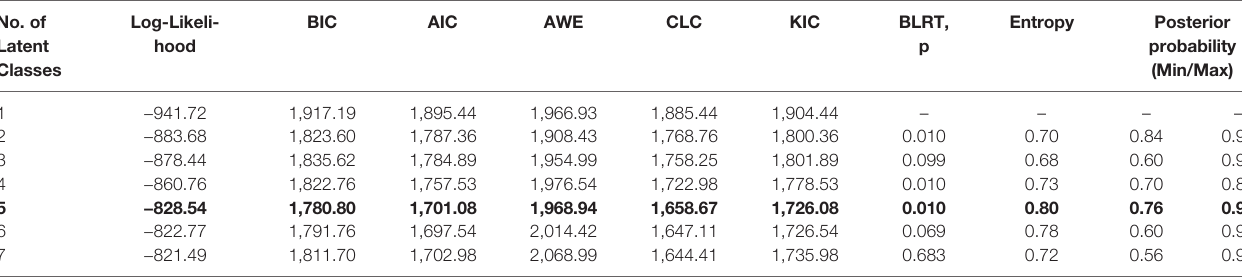
TABLE 1 | Model fi t of the latent pro fi le analysis with up to seven latent classes ( N = 277).